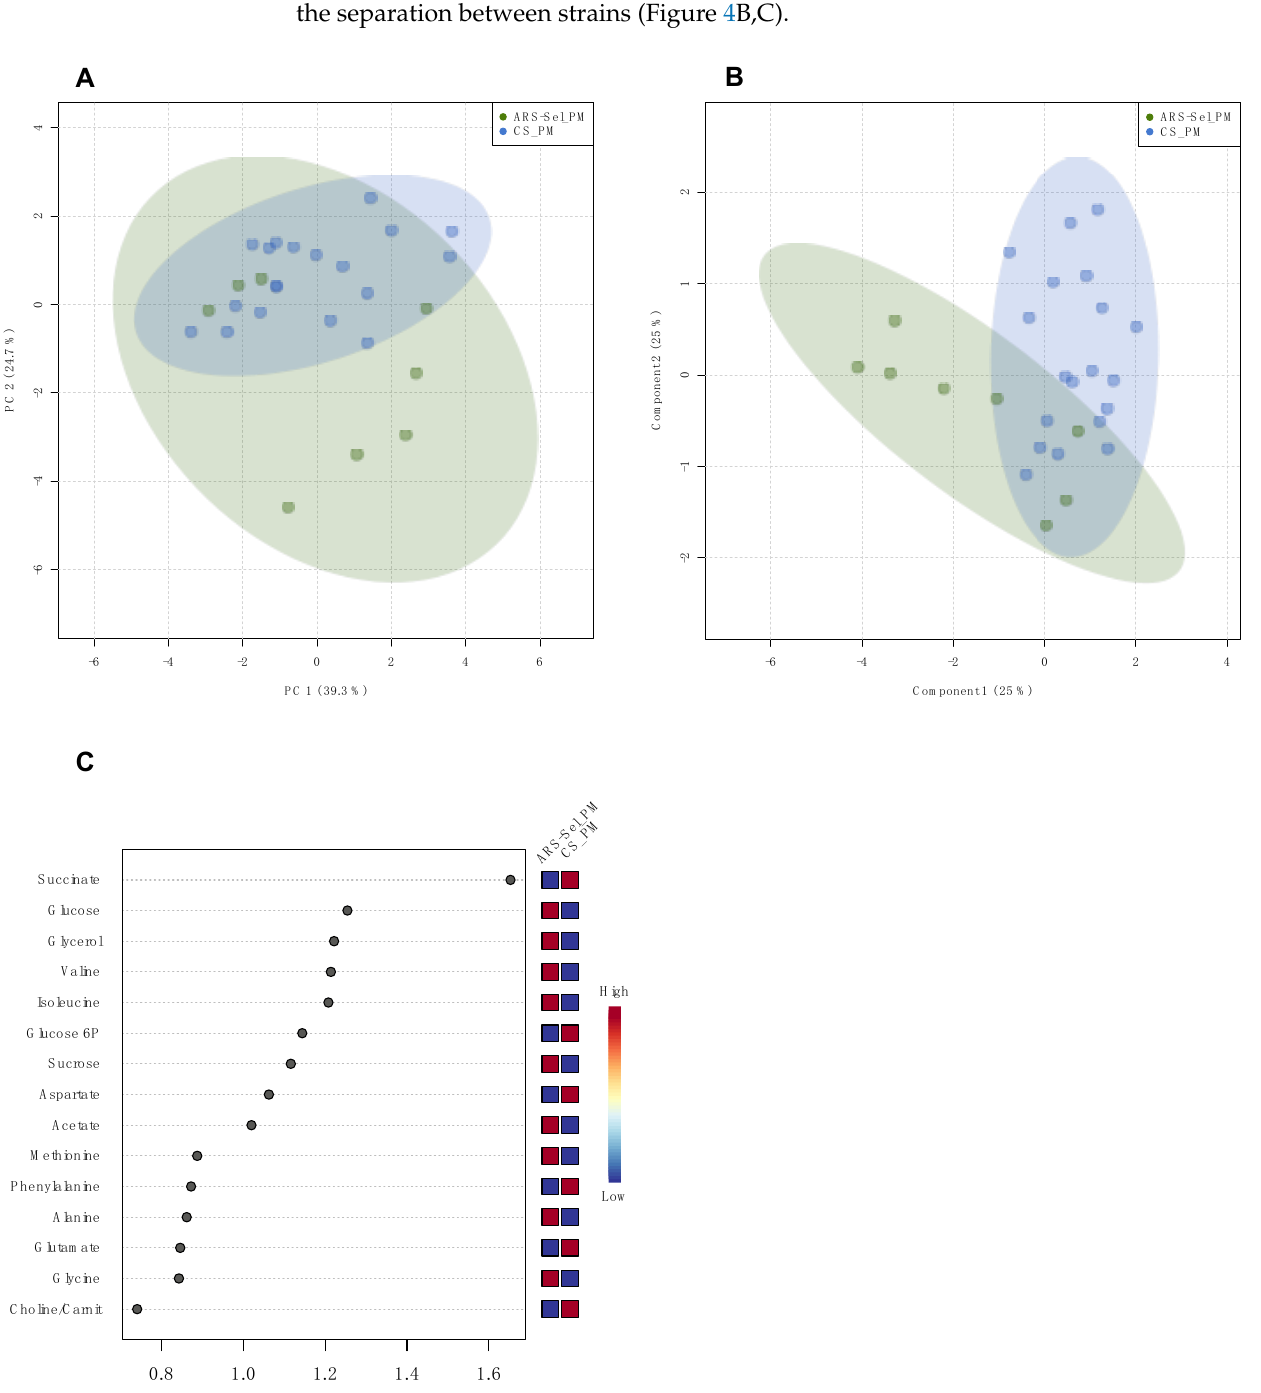
Table 2. Summary of the results of the pairwise multivariate analysis in plasma and digesta samples for fish strains sub- jected to the same diet: p -value of the permutation testing of the PLS models, and list of metabolites assigned as VIP (score ≥ 1).